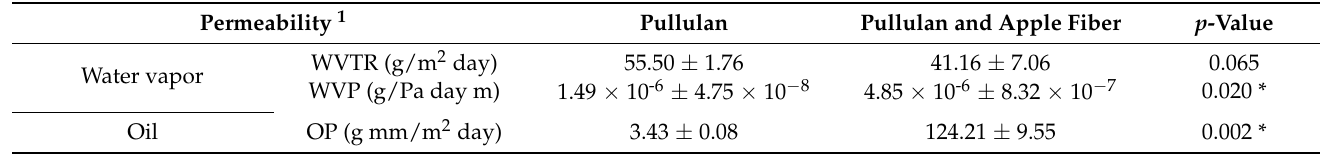
Table 2. Barrier properties of the biocomposite